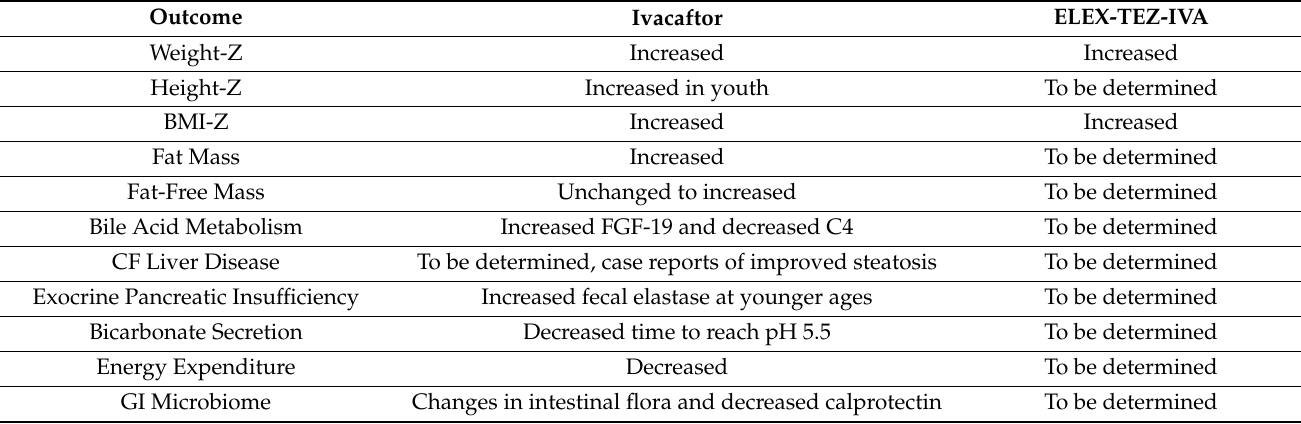
Table 1. Summary of the effects of highly effective CFTR modulators on markers of growth, nutritional status and gastrointestinal